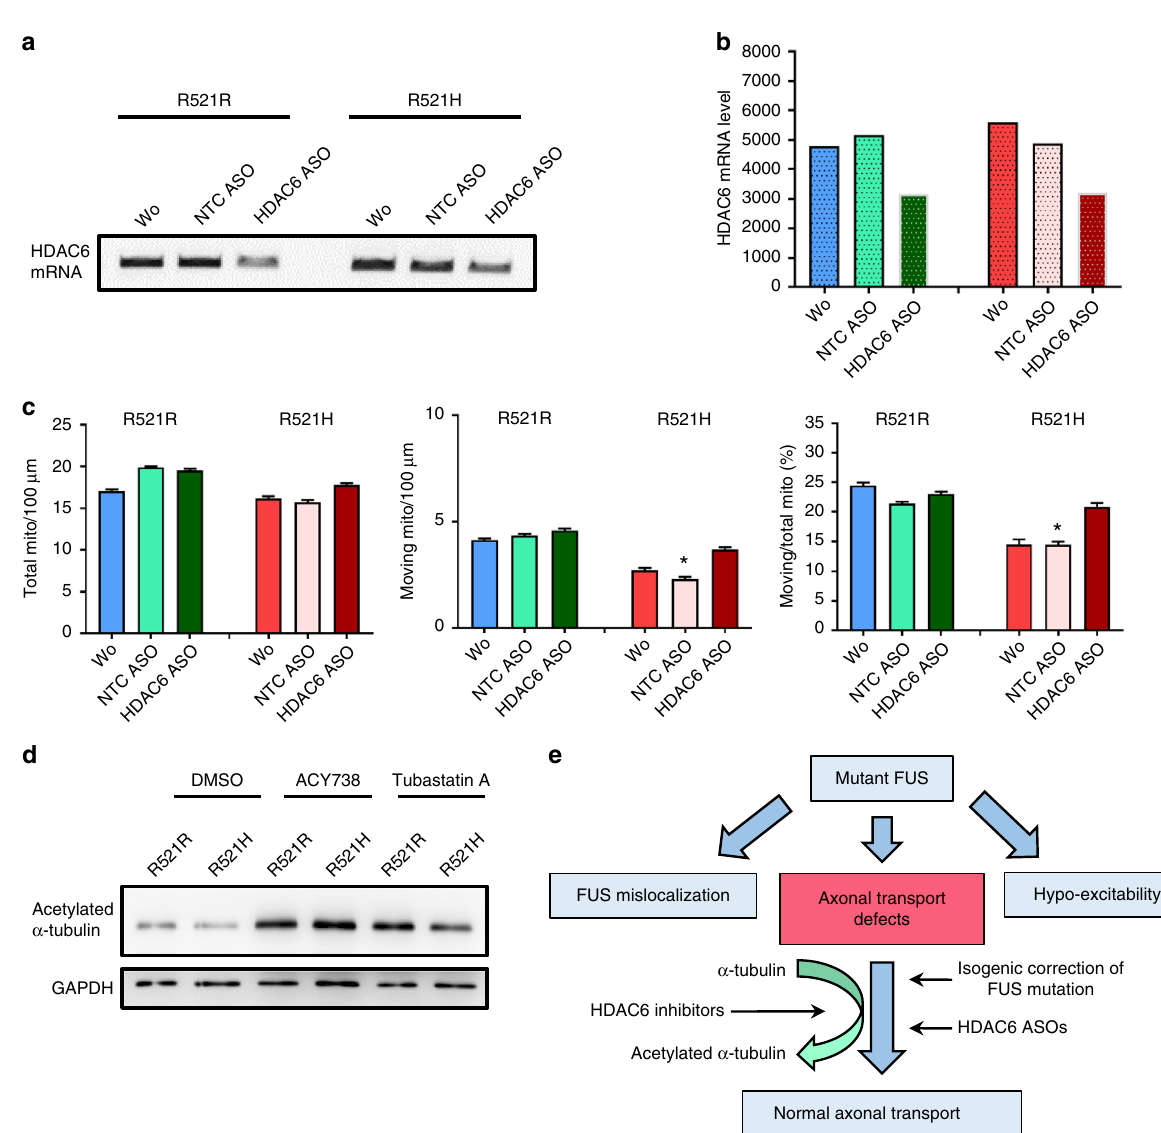
Fig. 6 Effect of genetic HDAC6 knockdown and increased acetylation levels of α -tubulin by HDAC6 inhibition. a RT-PCR validation of knockdown by an antisense oligonucleotide (ASO) against HDAC6 in MNs. b Quanti fi cation of the RT-PCR results of the gel shown in a illustrating the HDAC6 knockdown by the ASO. c Knockdown of HDAC6 using an ASO in patient-derived MNs increased axonal transport based on tracking mitochondrial movement (total number, moving number, and ratio between total and moving mitochondria). Scrambled ASO was used as a negative control (NTC ASO). n = 20, n = 19, n = 18, n = 10, n = 11, n = 10 for R521R, R521R + NTC ASO, R521R + HDAC6 ASO, R521H, R521H + NTC ASO, R521H + HDAC6 ASO, respectively; ANOVA with post-hoc Tukey ’ s test, * P value of 0.05. d Western blot from MNs (R521H mutant line 2/2 and isogenic control R521R), with and without treatment with ACY-738 or Tubastatin A at day 31 of differentiation. The blot was probed with antibodies directed to acetylated α -tubulin, and GAPDH. e Schematic representation of our results indicating that HDAC6 inhibition rescues axonal transport defects in FUS-iPSC-derived motor neurons through increasing acetylation levels of α of TARDBP , FUS , and C9orf72 17 . These axonal transport de fi cits